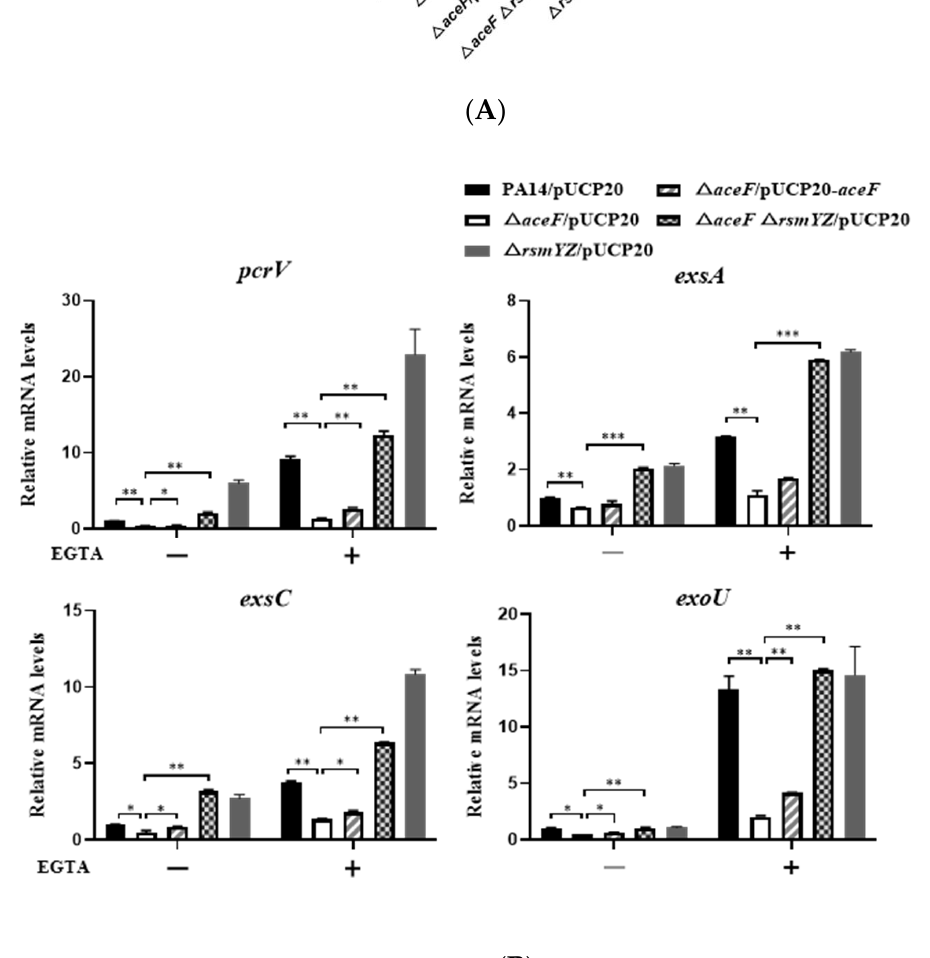
Figure 4. RsmY and RsmZ repress the T3SS in the Δ aceF mutant. ( A ) Cytotoxicity of wild-type PA14, the Δ aceF mutant, the complemented strain, the Δ aceF Δ rsmYZ triple mutant and Δ rsmYZ double mutant. A549 cells were infected with the bacteria for 3 h (MOI = 50). The cytotoxicity was determined by measuring crystal violet-stained cells. ( B ) mRNA levels of the T3SS genes. Bacteria were grown in the presence and absence of 5 mM EGTA for 4 h. The relative mRNA levels of pcrV , exsA , exsC and exoU were determined by real-time PCR. Data shown represent mean ± standard error of mean from three samples. * p < 0.05; ** p < 0.01; *** p < 0.001 by ANOVA.